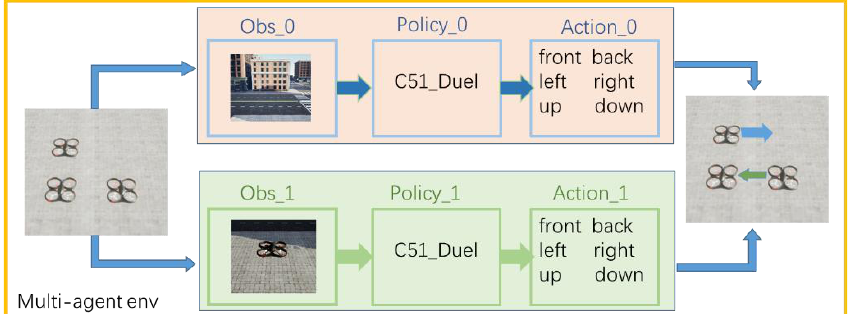
Figure 3. Path planning for multiple UAVs using independent policy.